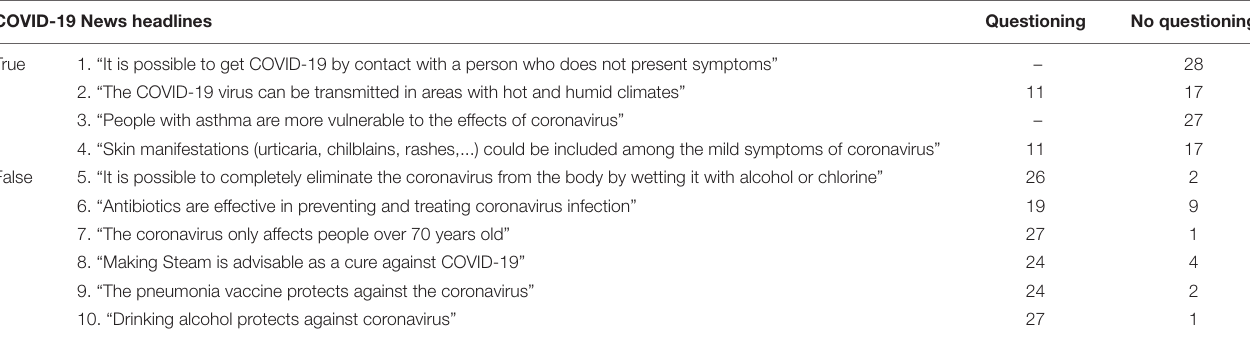
TABLE 3 | Number of students who questioned or not each news headline on COVID-19. COVID-19 News